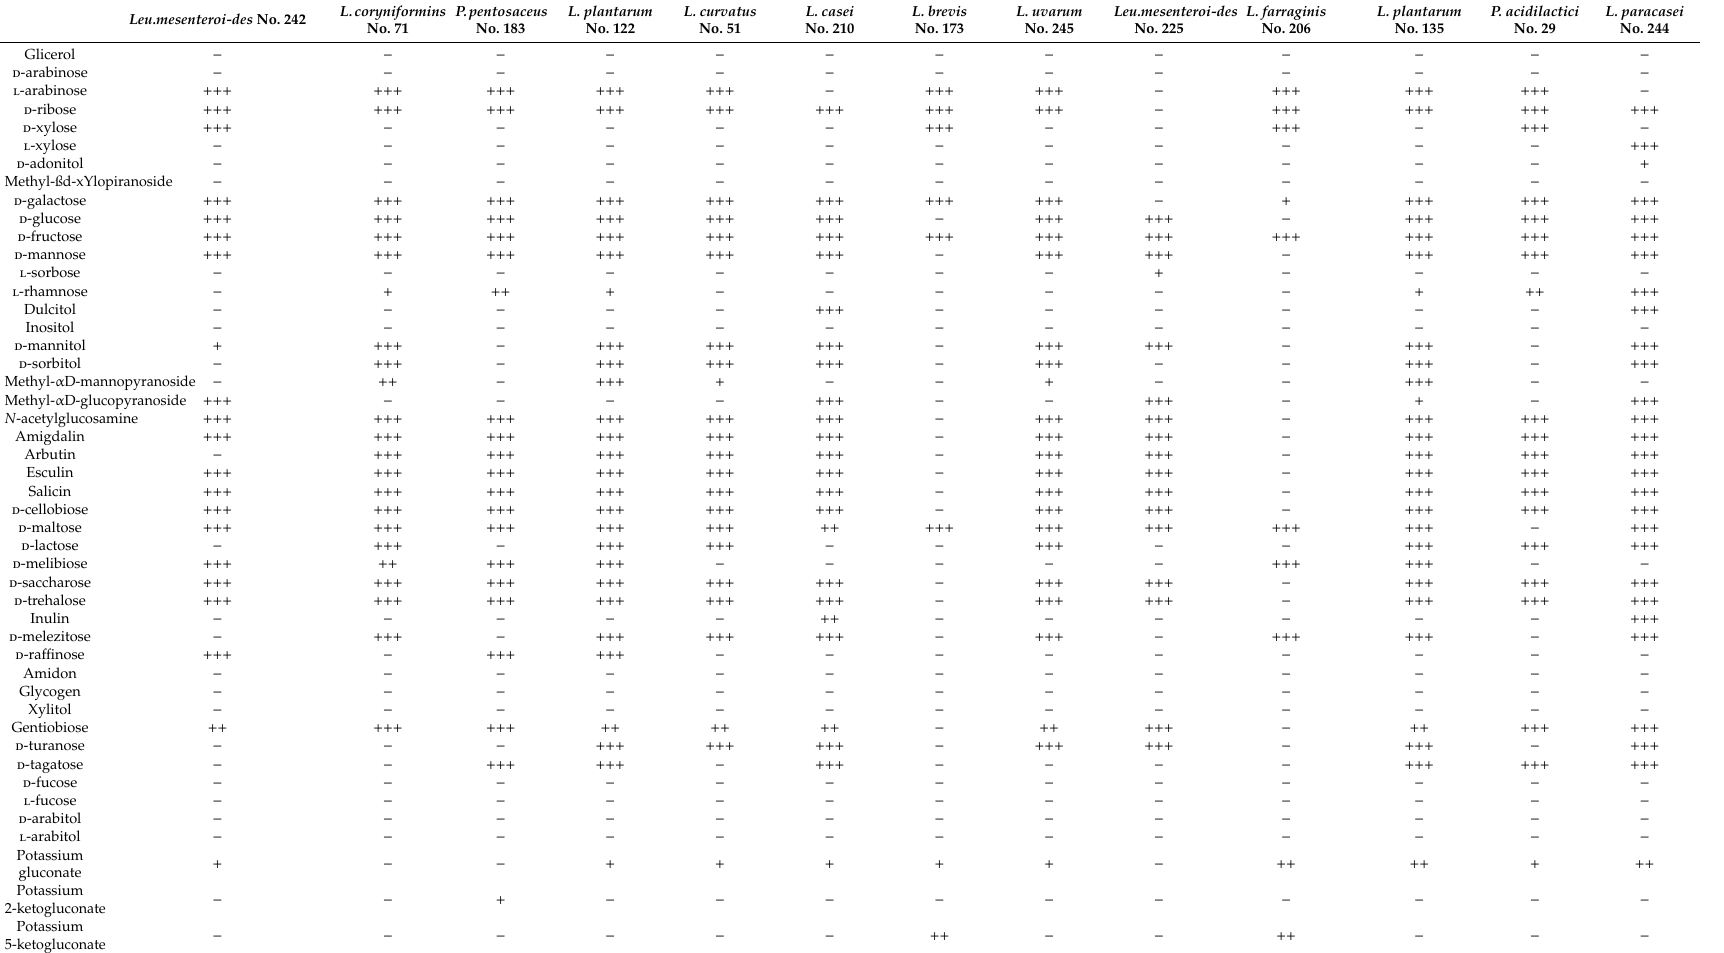
Table 3. Carbohydrate metabolism, gas production, tolerance to temperature (10, 30, 37 and 45 ◦ C) and low pH conditions (pH 2.5 for 2 h) of the isolated sourdough lactic acid bacteria (LAB)